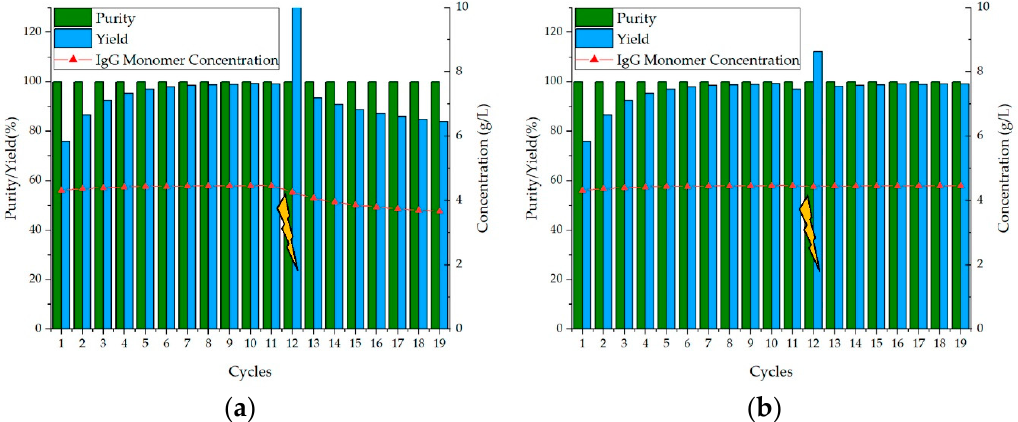
Figure 16. Purity, Yield and concentration course over cycles. ( a ) is without process control, ( b ) is with valve control via PAT concentration measurement. Concentration disturbance occurs in cycle 11.